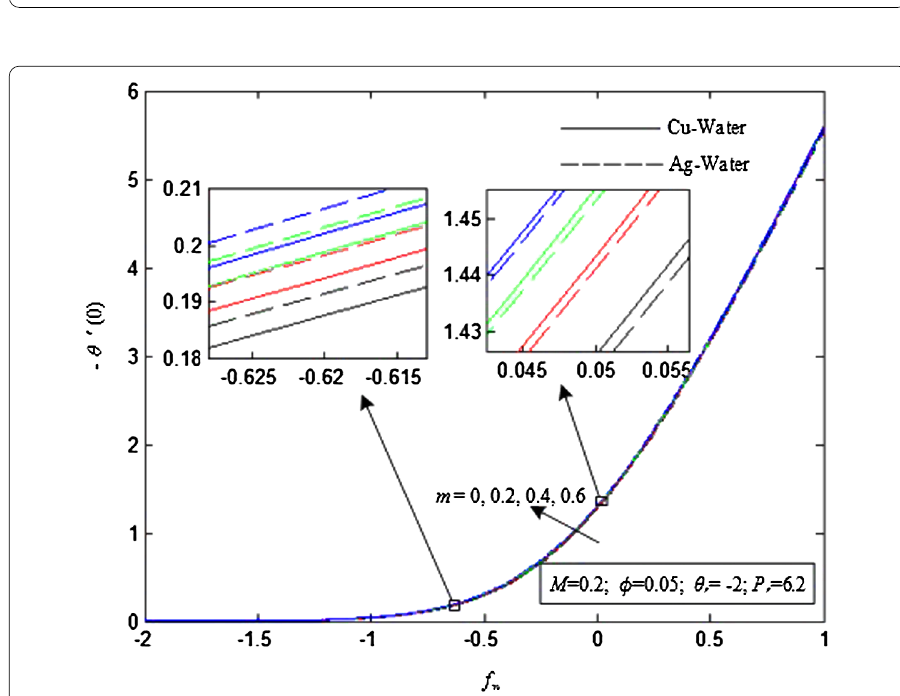
Figure 10 Rate of heat transfer coefficient as a function of f w for representative values of m .